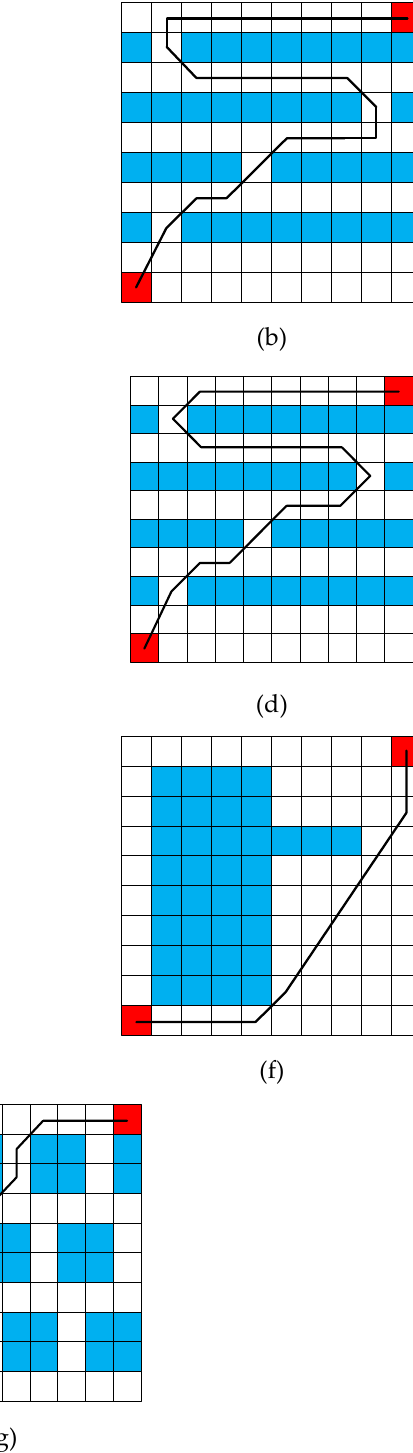
Figure 13. The best path with the rest environment ( a ) 10_4ch (Wavefront); ( b ) 10_4ch (ACO); ( c ) 10_4ch (SA, PSO); ( d ) 10_4ch (Others); ( e ) 10_1o (Wavefront); ( f ) 10_1o (Others); and, ( g ) 10_11s (all algorithms) .